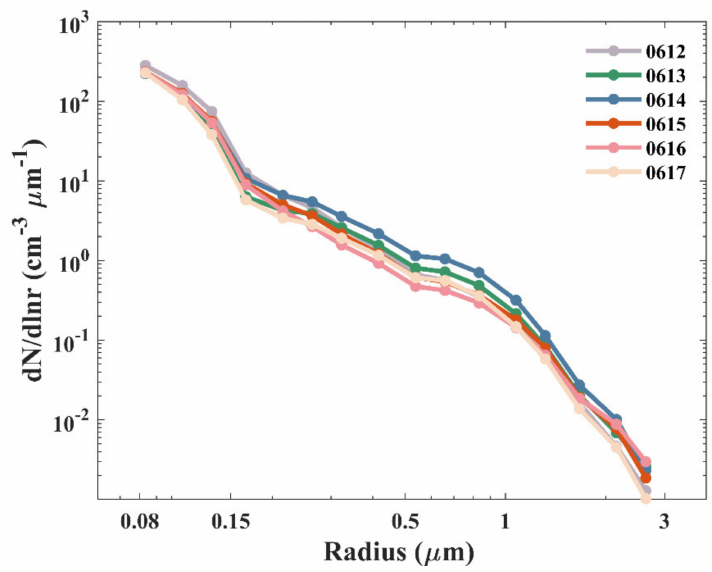
Figure 8. Daily particle size spectrum measured from 12 to 17 June